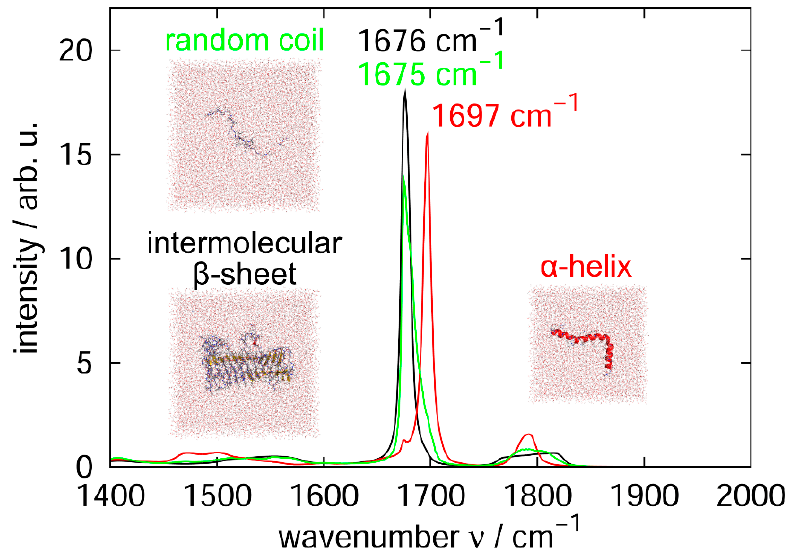
Figure 18. Infrared absorption spectra of the backbone C=O stretching vibration that forms the am- yloid fibril (black), α -helix (red), and random coil (green). The snapshot images were created using PyMOL [171]. Reprinted in part with permission from Ref. [84]. Copyright 2021 American Chemical Society.